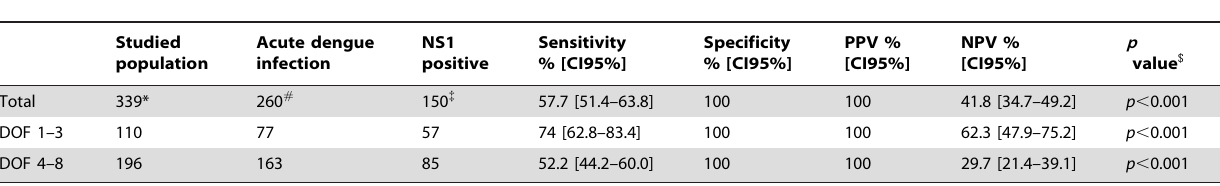
Table 2. Sensitivity, specificity, positive and negative predictive values of Platelia NS1 assay against dengue-confirmed cases.